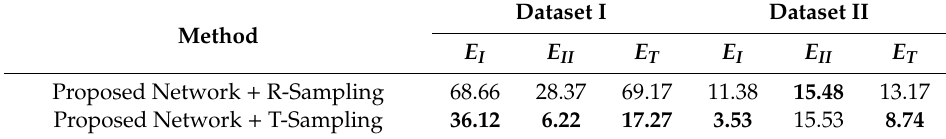
Table 3. Comparison of R-Sampling and T-Sampling algorithm on dataset I and II.